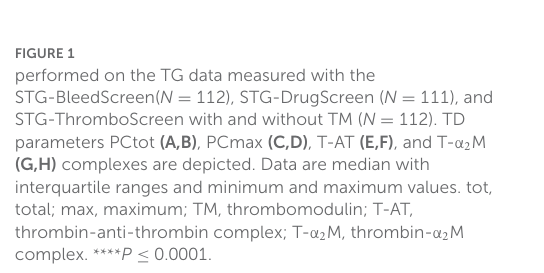
FIGURE1 performed on the TG data measured with the STG-BleedScreen( N = 112), STG-DrugScreen ( N = 111), and STG-ThromboScreen with and without TM ( N = 112). TD parameters PCtot (A,B) , PCmax (C,D) , T-AT (E,F) , and T- α 2 M (G,H) complexes are depicted. Data are median with interquartile ranges and minimum and maximum values. tot, total; max, maximum; TM, thrombomodulin; T-AT, thrombin-anti-thrombin complex; T- α 2 M, thrombin- α 2 M complex. **** P ≤ 0.0001.